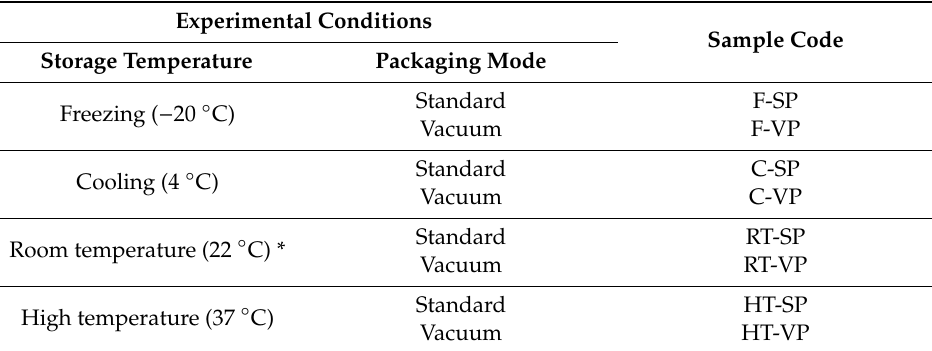
Table 1. Experimental conditions and sample